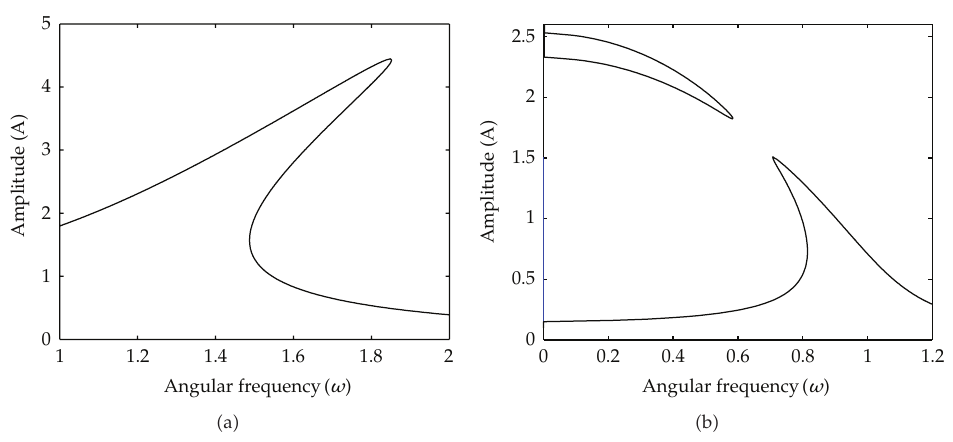
Figure 3: The amplitude depending on frequency ω for hardening (cid:5) a (cid:6) and softening (cid:5) b (cid:6) springs.